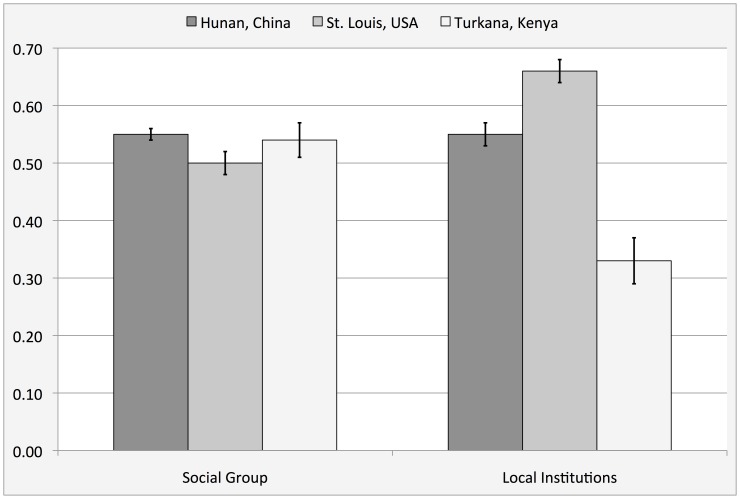
Trust in social group (an equivalent of social capital) and trust in local institutions in three cultures.